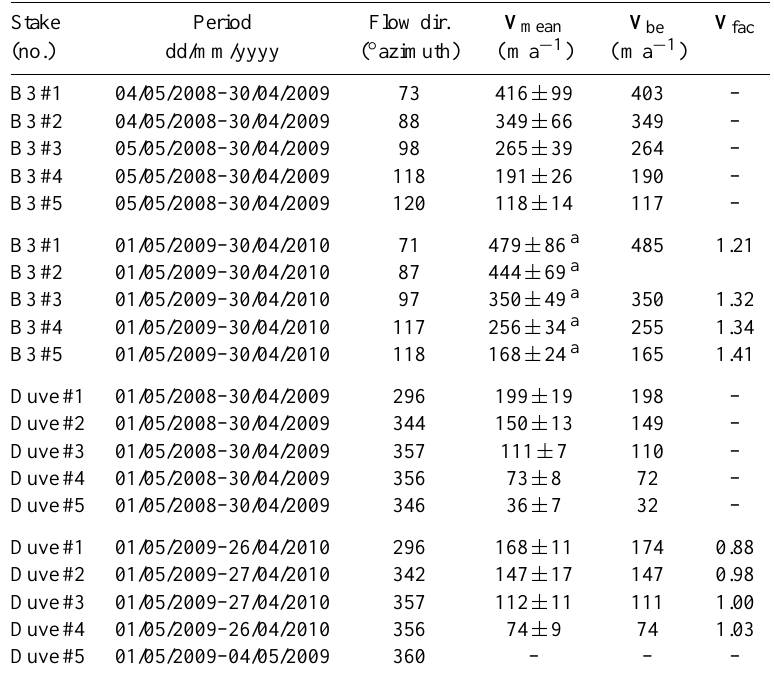
Table 2. Annual mean velocities for the period May 2008–2009 and May 2009–2010 based either on all available daily values ( V mean ) or the first and last day’s position at the beginning and end of the respective year ( V be ). The velocity factor, V fac , refers to current vs. previous year’s V be . At Basin-3, data is lacking between ∼ 15 June–25 August, including both the pre-summer minimum and summer speed-up/maximum. The corresponding entry for V mean is marked by a .